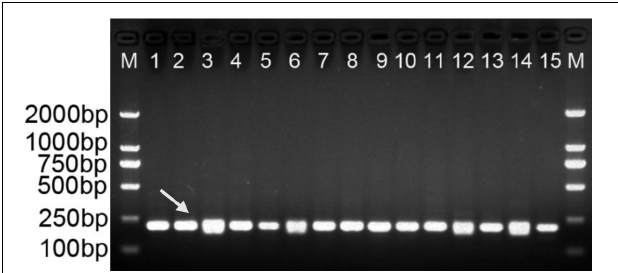
FIGURE 4 | Amplification profiles of the primer pair SHF/SHR in 15 D. officinale individuals. Lane 1 ∼ 15: Details of 15 D. officinale individuals are provided in Table 2 . Lane M: Trans2K DNA Marker with lengths (bp); Arrowheads represent specific amplified bands in all the D. officinale individuals.